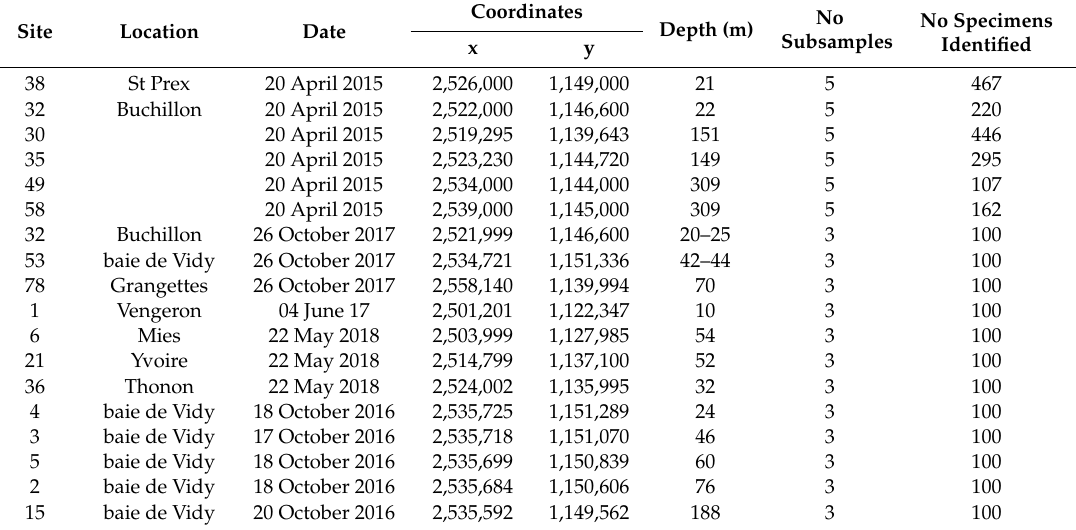
Figure 1. Map of all the studied sites in Lake Geneva, with indication of the analyses (morphology, genetic) performed per site. Table 1. Details of the sampling and number of specimens identified per site. The Swiss coordinate system (1903) was used.